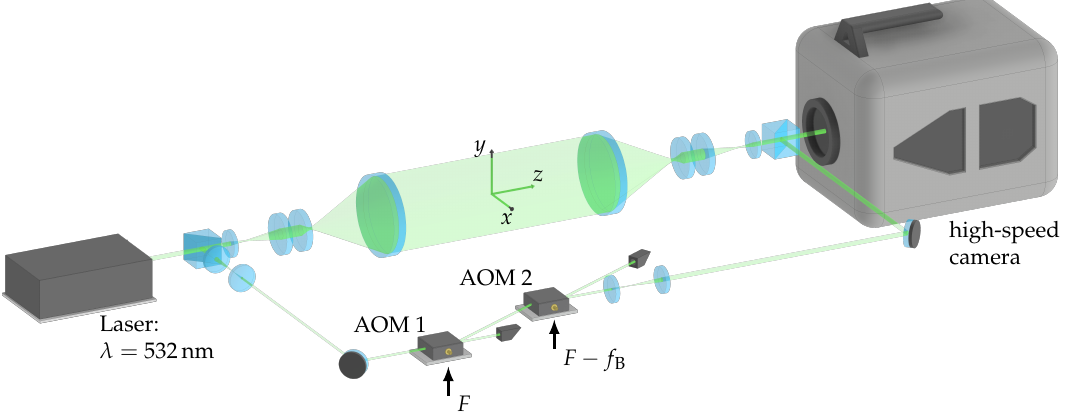
Figure 1. Measurement principle of the heterodyne Mach–Zehnder interferometer. Laser: λ = 532 nm, solid state laser; camera: 64 × 1024 Pixel, f B : 30 kHz, field of view: 2 × 30 mm, frame rate: 120 kHz. Taken from